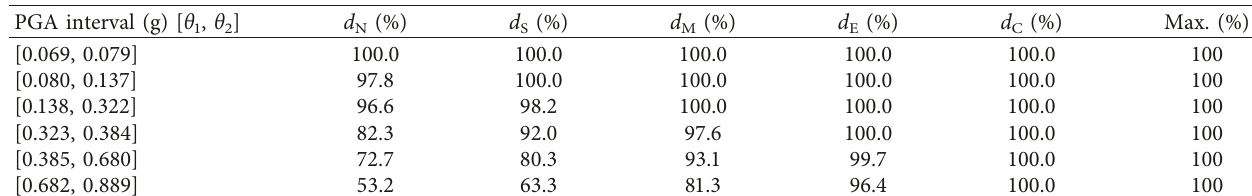
Table 4: Assigning π based on the degree of belief m in Table 3.